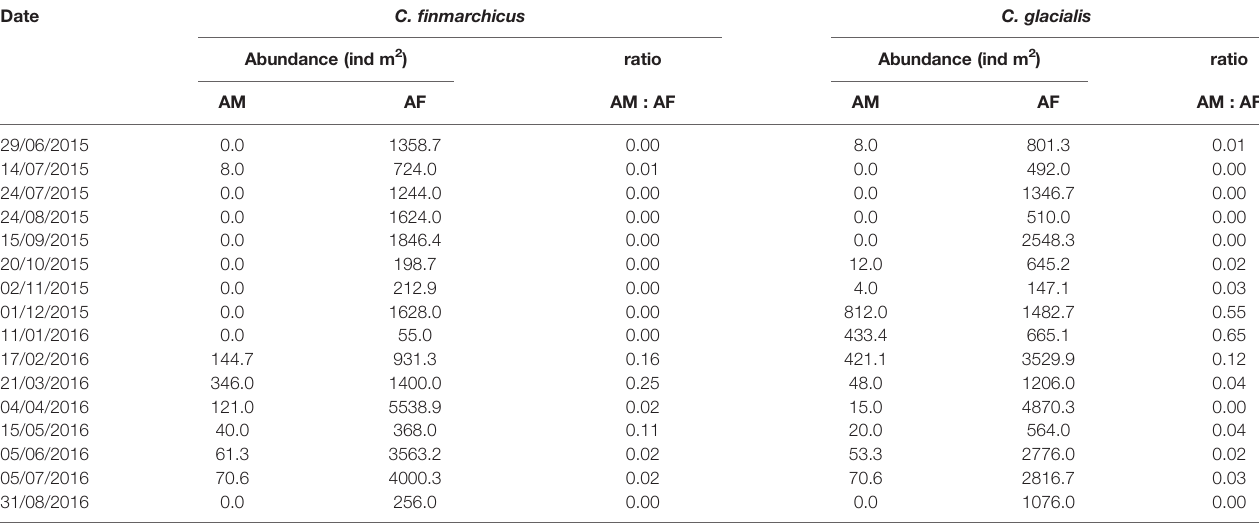
TABLE 4 | Seasonal variations in abundance of adult males (AM) and adult females (AF) and sex ratio (males:females) of C. fi nmarchicus and C. glacialis